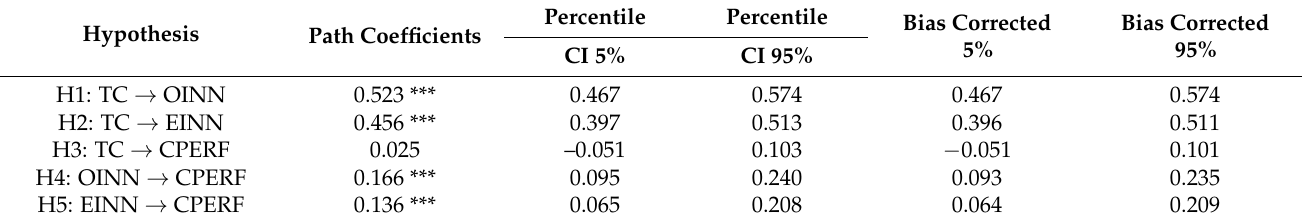
Table 7. Percentile confidence interval (CI) and